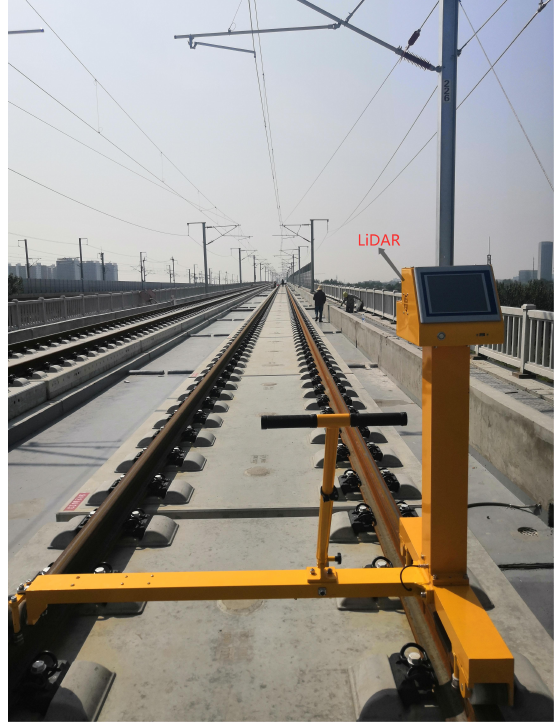
Figure 7. The actual inspection